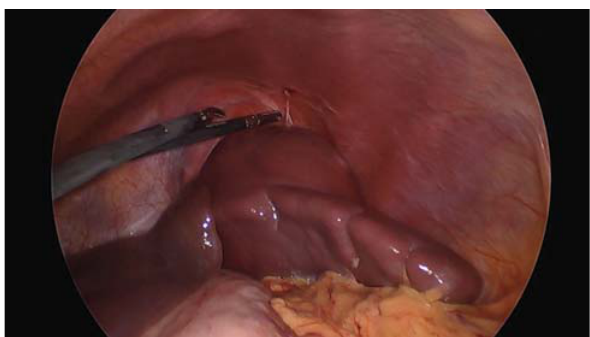
Fig. 2 Intraoperative image before beginning dissection. To the left of the image, the left hepatic lobe is seen covering the upper pole of the spleen. The spleen presents a large cyst on the superolateral aspect with diaphragmatic